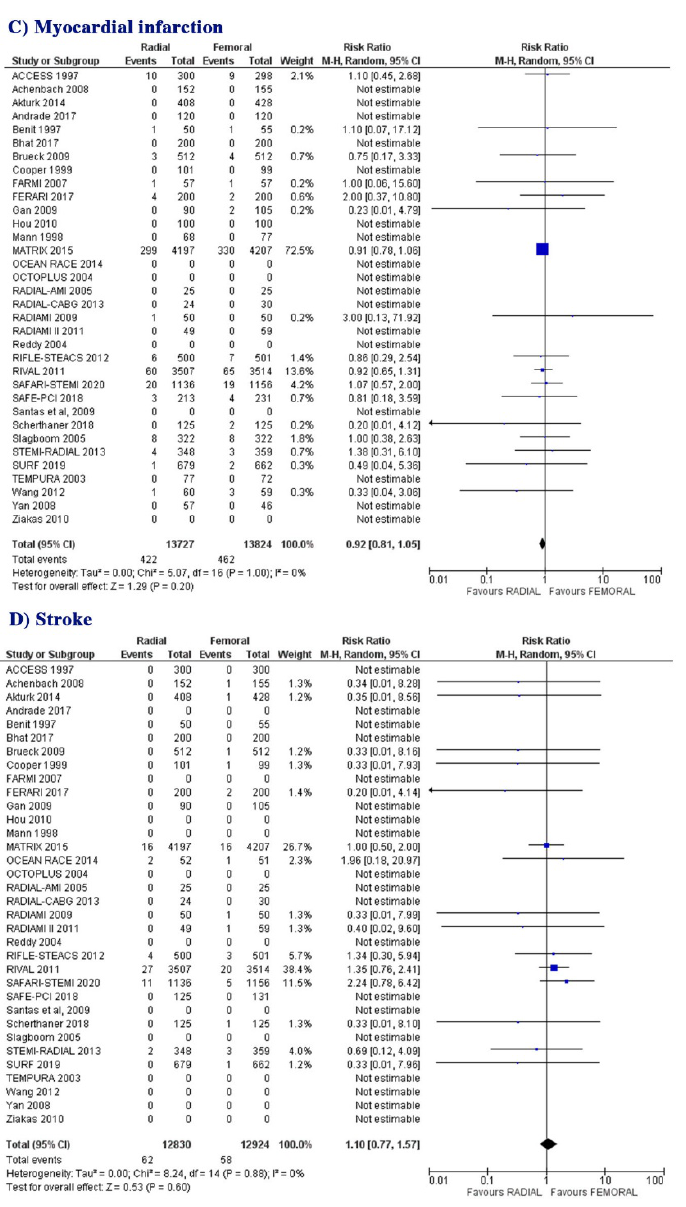
Figure 3. Risk of MACE ( A ) and major vascular complications ( B ) at follow-up: radial vs. femoral, in whole group of patients.Risk of myocardial infarction ( C ) and stroke ( D ) at follow-up: radial vs. Femoral, in whole group of patients.